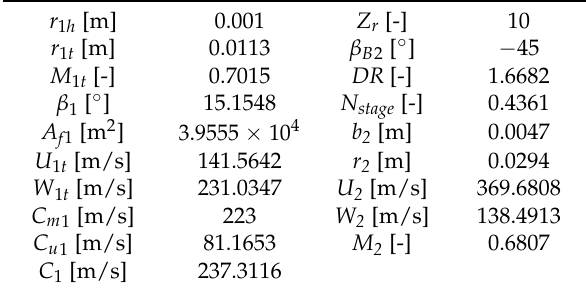
Table 9. Optimization results for B = 0.02 and N = 120,000